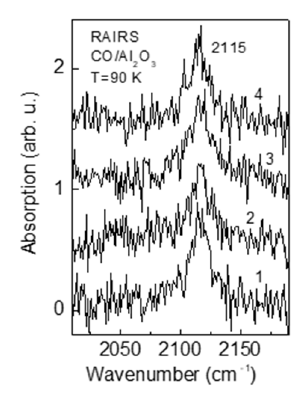
Figure 2. RAIR spectra in CO stretch region, obtained after 200 L-exposure of CO of alumina films 2 mL (1), 4 mL (2), 6 mL (3), and 8 mL (4) thick, held at a temperature of 90 K. Morphology of Au overlayers, deposited in an equivalent amount of 0.7 MLE onto alumina films of different thicknesses held at 500 K to achieve equilibration, demonstrates similarity of the Auger Au NVV to Al LVV intensity ratio (Figure 1e,f)—the value charac- terizing the relative area of the substrate covered by the adsorbate [19,33]. According to the DFT calculations of Jennison and coworkers [34,35], the Au bounds to α -Al 2 O 3 (1000)